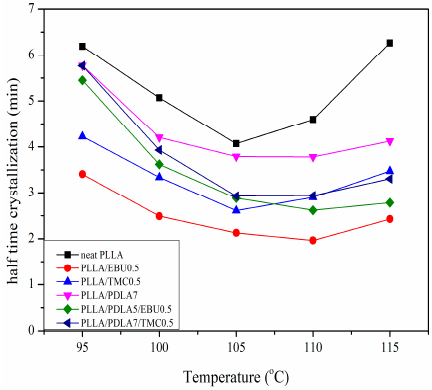
Figure 7. Dependence of half-time crystallization on crystallization temperature of nucleated PLLA. Table 3. Kinetics parameters obtained from the isothermal crystallization of nucleated PLLA